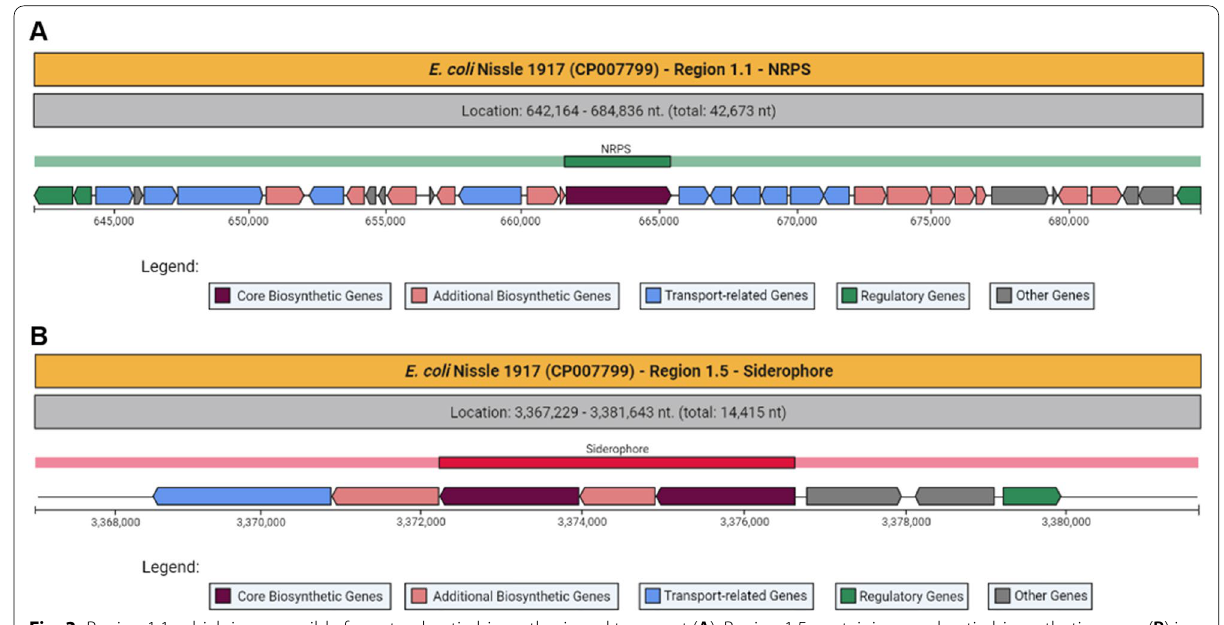
Fig. 3 Region 1.1, which is responsible for enterobactin biosynthesis and transport ( A ); Region 1.5 containing aerobactin biosynthetic genes ( B ) in